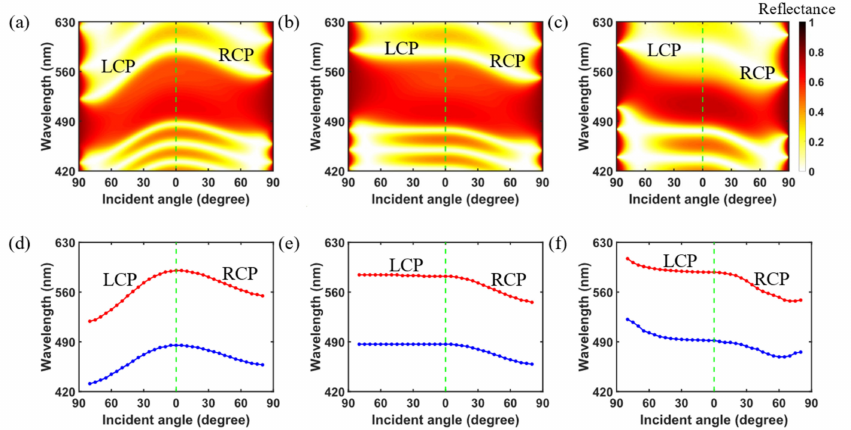
Figure 4. Reflectance spectra of ( AB ) versus incident angles for LCP and RCP waves. ( a ) d A = 6 228 nm, d B = 20nm and κ = 0.05 + 0.01 i . ( b ) d A = 228 nm, d B = 20 nm and κ is taken from Figure 2b. ( c ) d A = 274 nm, d B = 20 nm and κ is taken from Figure 2b. ( d – f ) Gap edges corresponding to ( a – c ), respectively. The red (blue) solid line represents the upper (lower) band